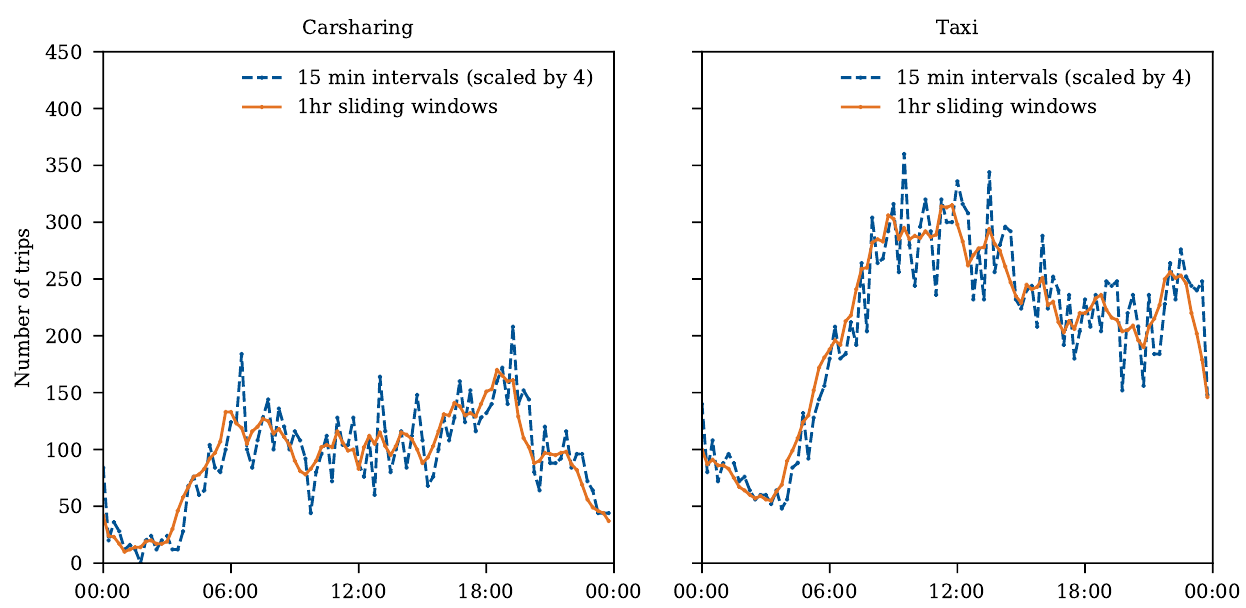
Figure 6. Number of Carsharing and Taxi Trips during Example Week with and without